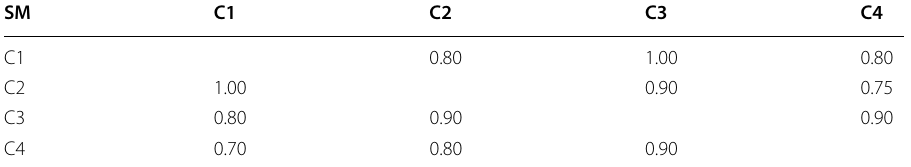
Table 7 Collective similarity matrix for the equity-based crowdfunding alternative